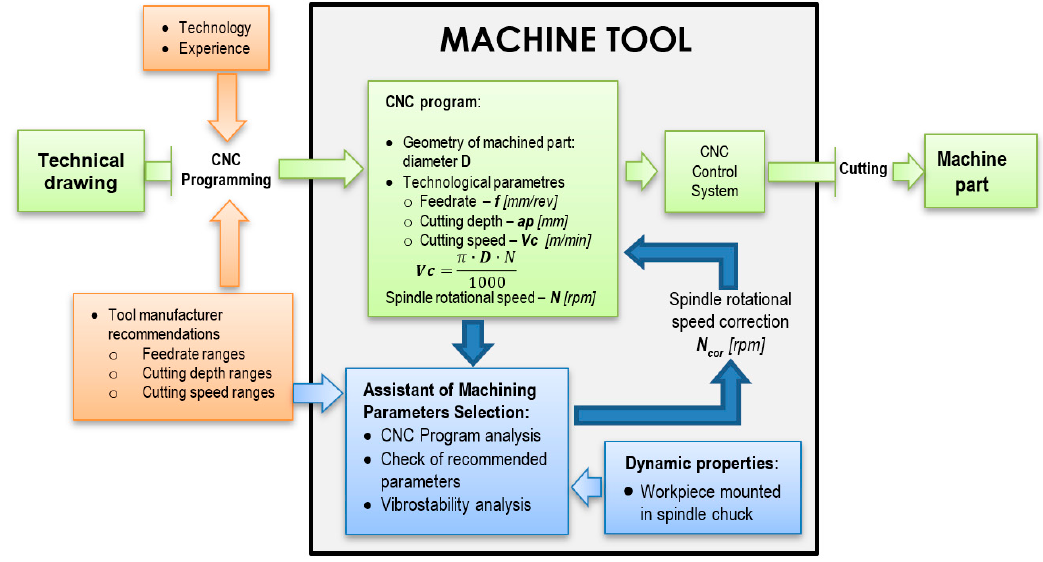
Figure 5. Algorithm of the Assistant of Machining Parameters Selection.